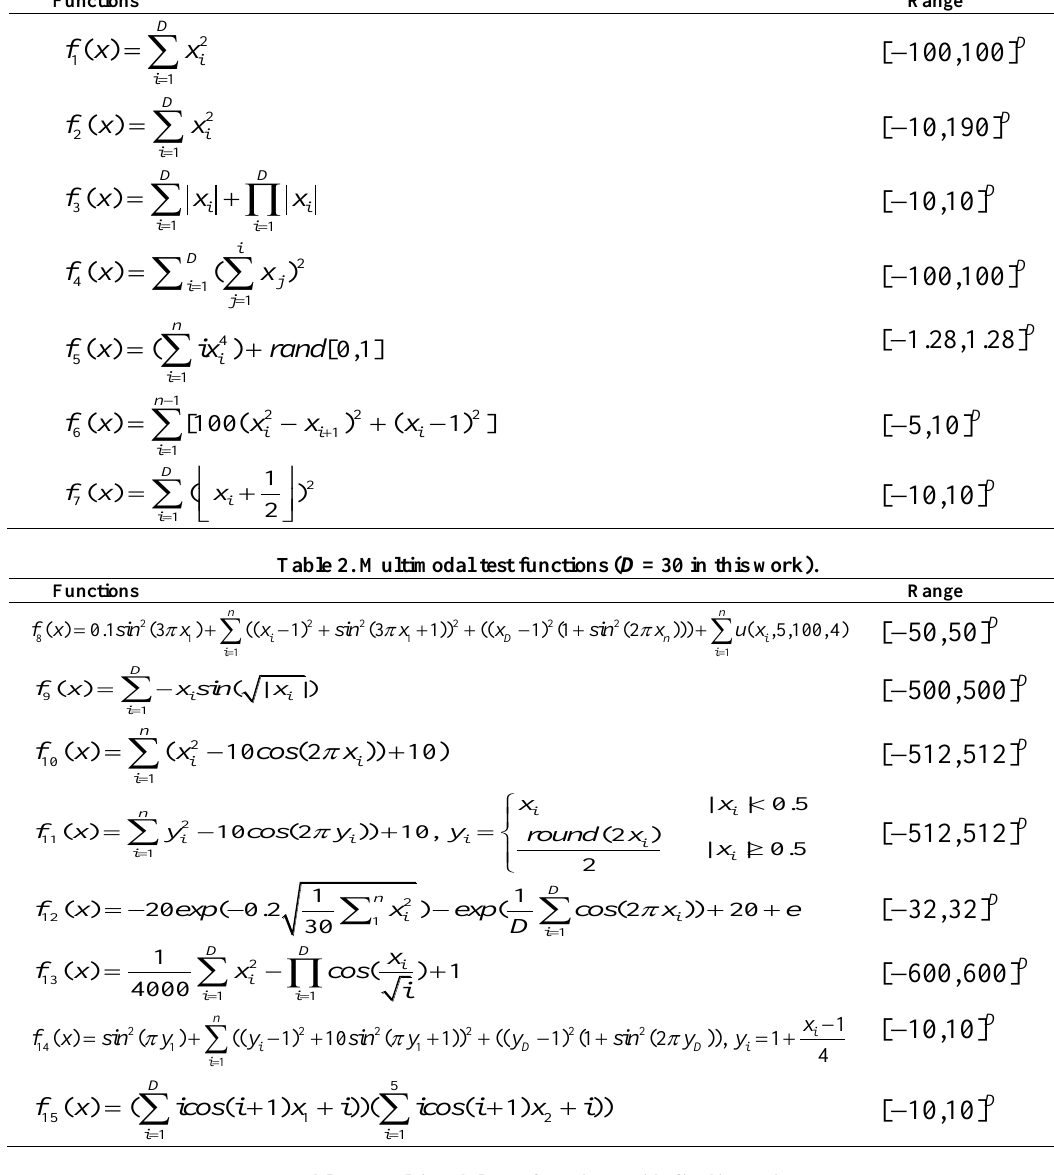
Table 3. Multimodal test functions with fix dimension.